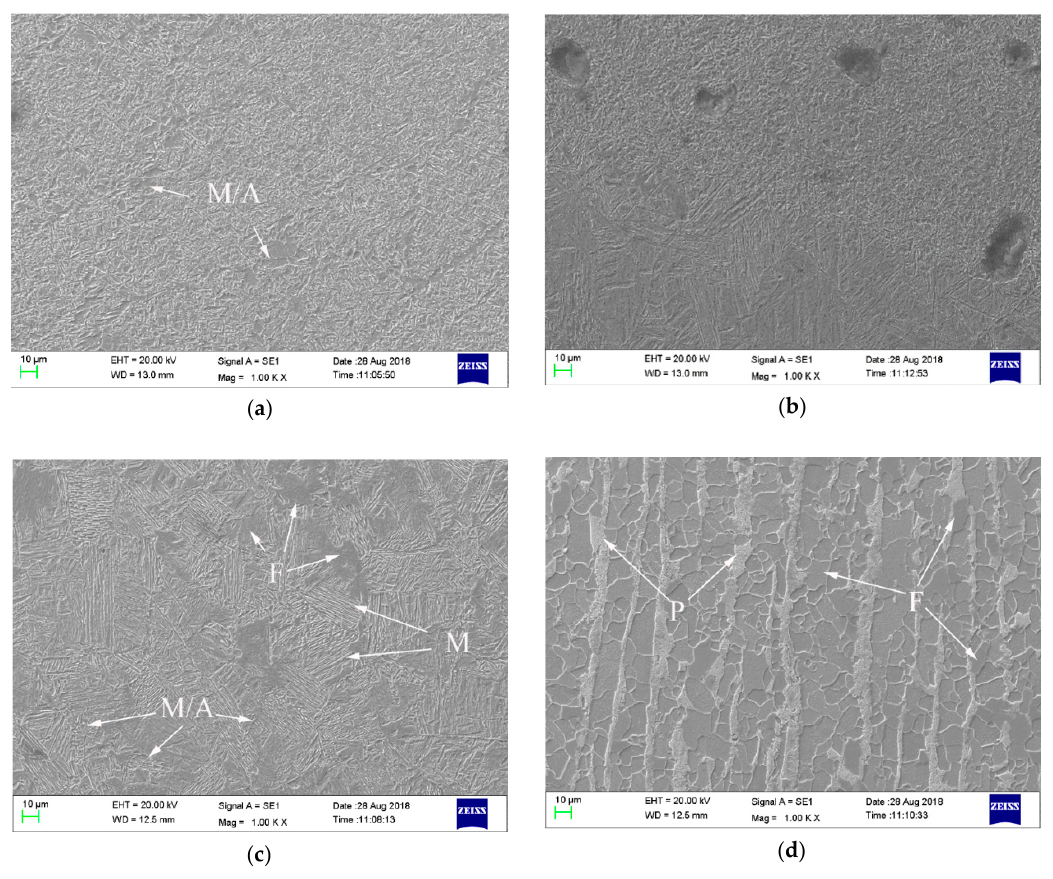
Figure 3. Microstructure of T-welded joints: ( a ) WZ, ( b ) FZ, ( c ) HAZ, and ( d ) BM.